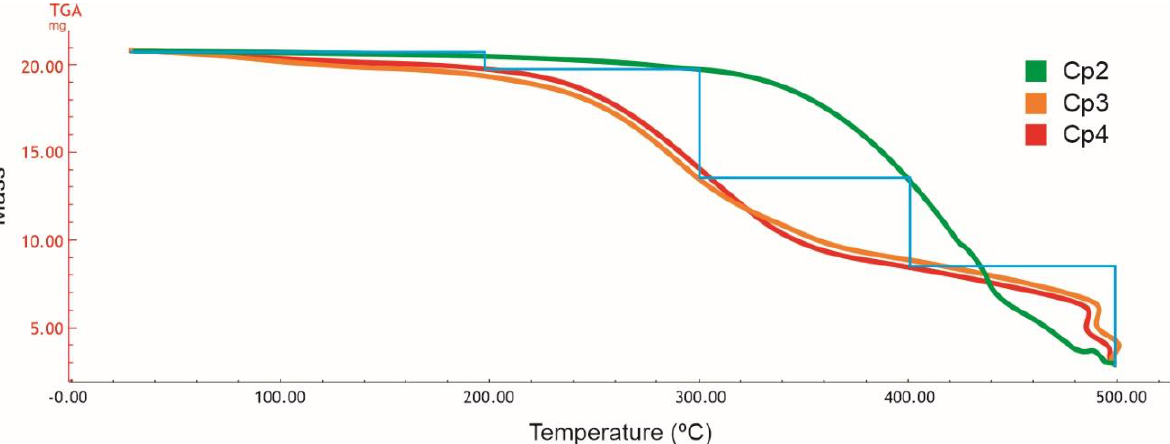
Figure 4. Thermal analysis curves for pure cured epoxidized waste oil (CP2) and for particleboard specimens with 20 and 30% CCWW in an epoxidized waste oil – DGEBA matrix (respectively, CP3 and CP4).